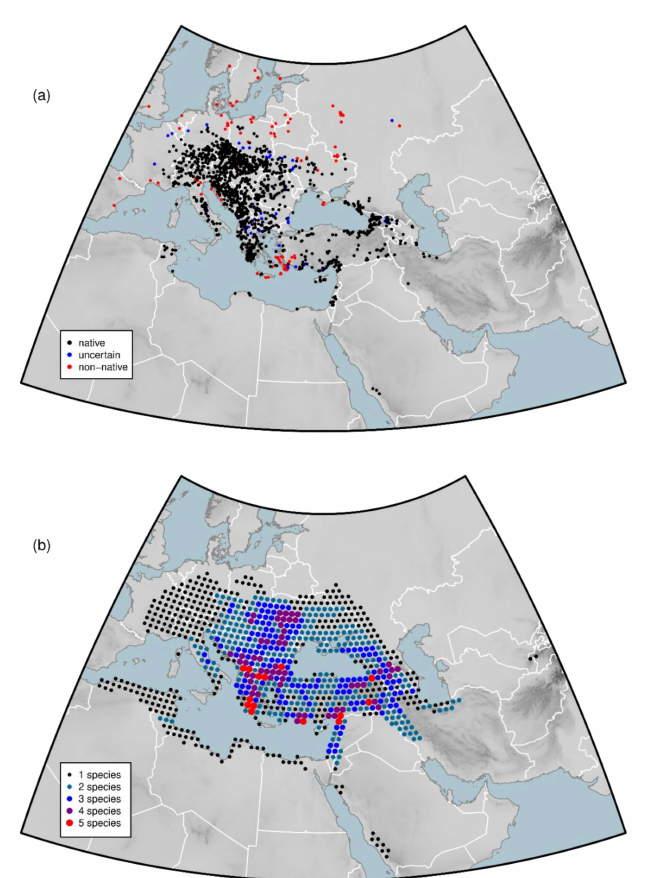
Figure 2. ( a ) sites of origin of the mitochondrial sequences in the tribe Helicini collated here and ( b ) a schematic representation of the spatial distribution of species diversity in the tribe. Sampling sites where only (presumably) non-native species have been sampled are shown in red, those